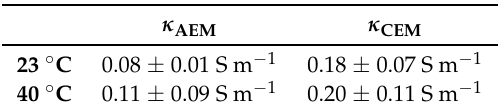
Table 6. Measured membrane ion conductivity for the relevant mean concentration of KNO 3 for the inlet to RED, 23 ◦ C and 40 ◦ C.